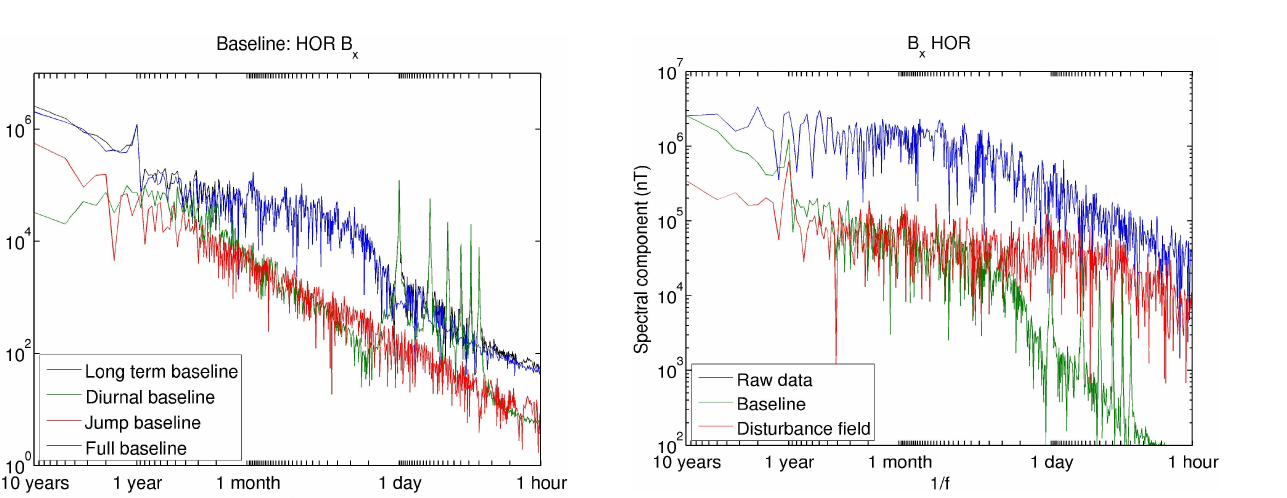
Fig. 11. Spectra of the different baseline components, of the B x field in Hornsund: blue: long-term baseline; green: diurnal baseline; red: jump baseline; black: full baseline. The x axis labels show the inverse of the frequency f .